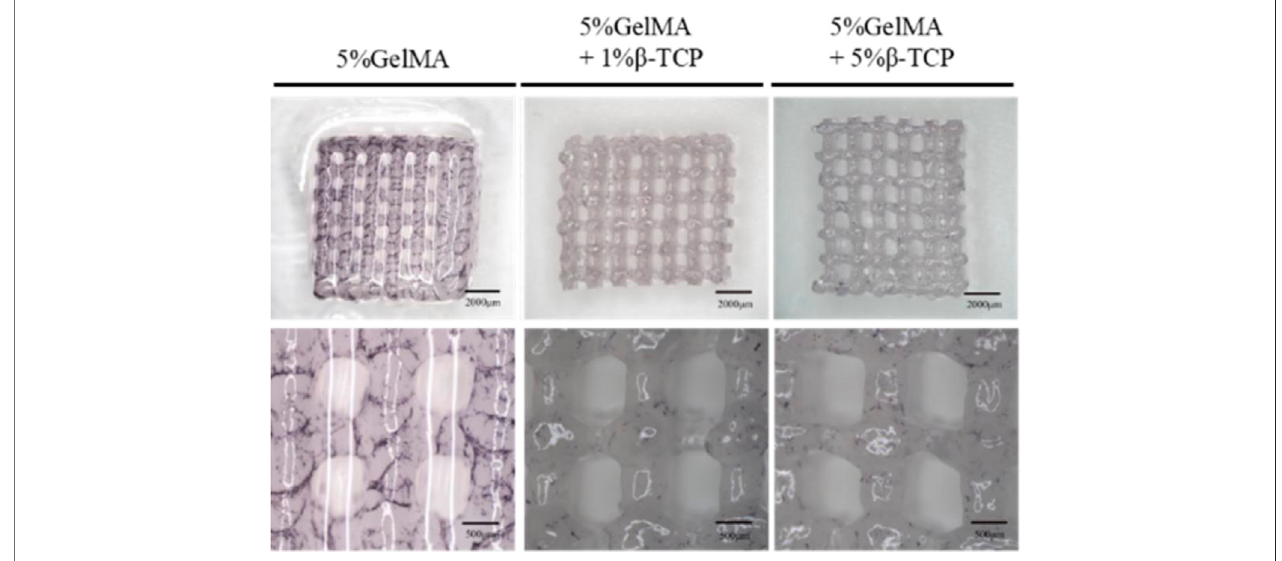
FIGURE6| OsteogenicabilityofratBMSCsattachedtothesurfaceoftheGelMA/ β -TCPhydrogelmaterial.ThehybridhydrogelscaffoldsloadedwithBMSCswere cultured continuously for 21 days. ALP reaction was performed in the scaffolds, and then images were captured by optical microscope.